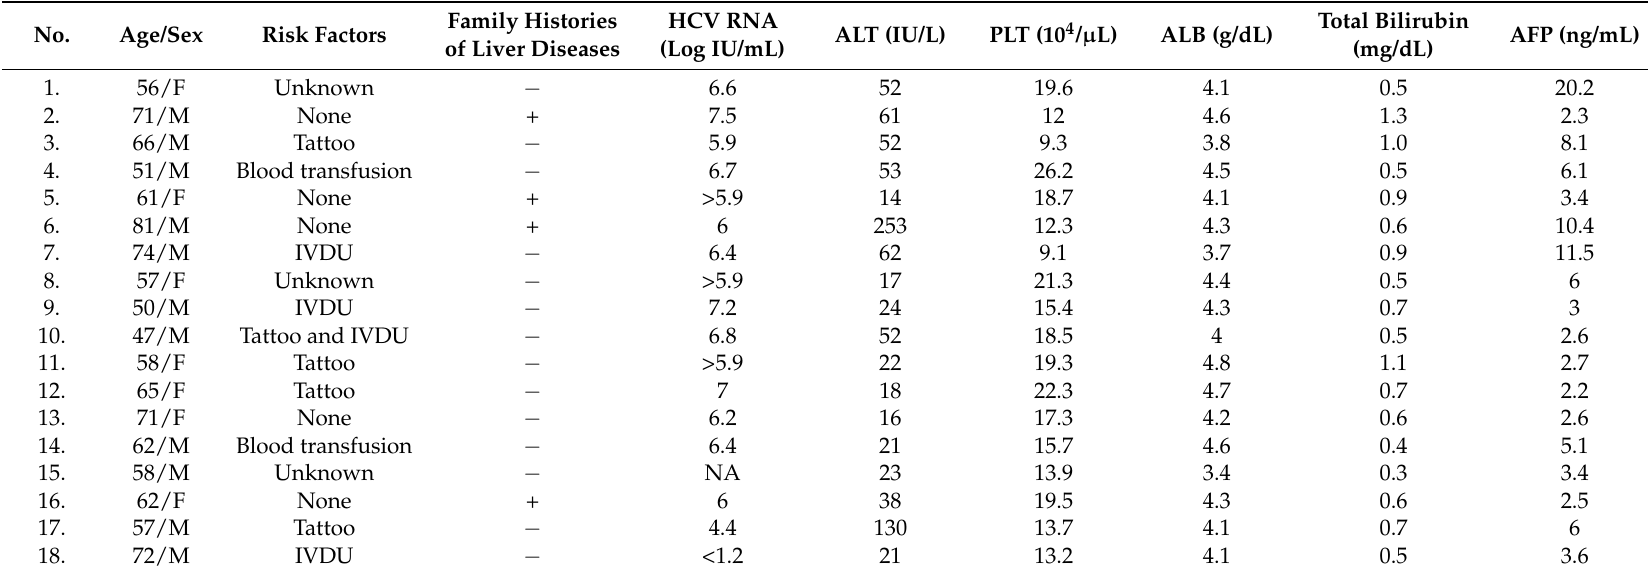
Table 1. Background of patients enrolled in the present